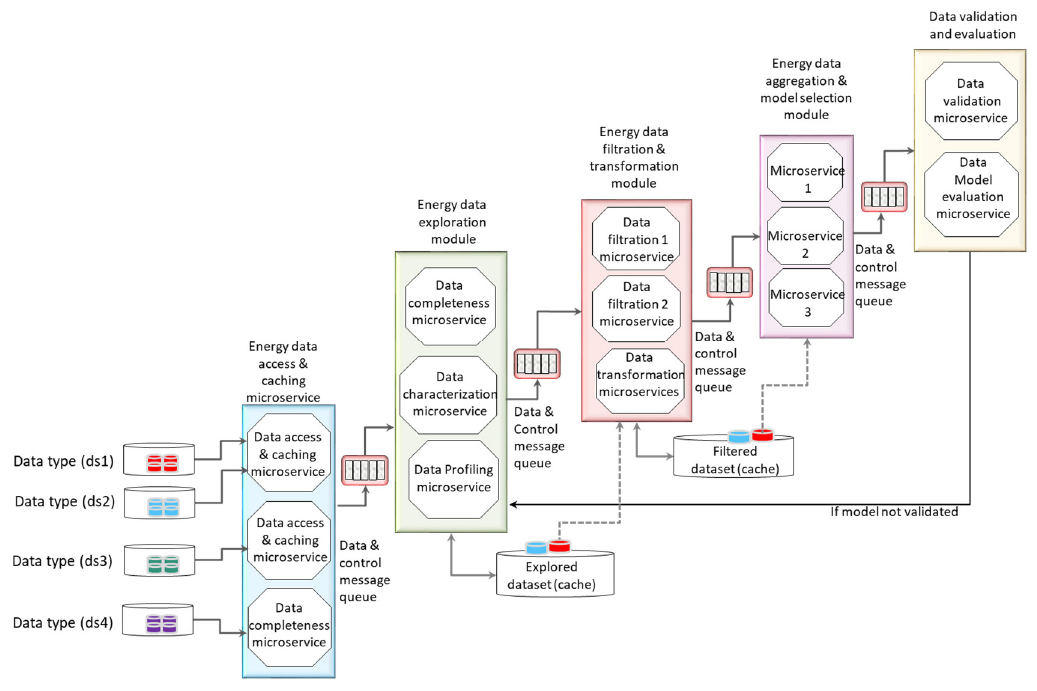
Figure 3. Microservices-based data processing and analysis functions to improve data availability for the services.